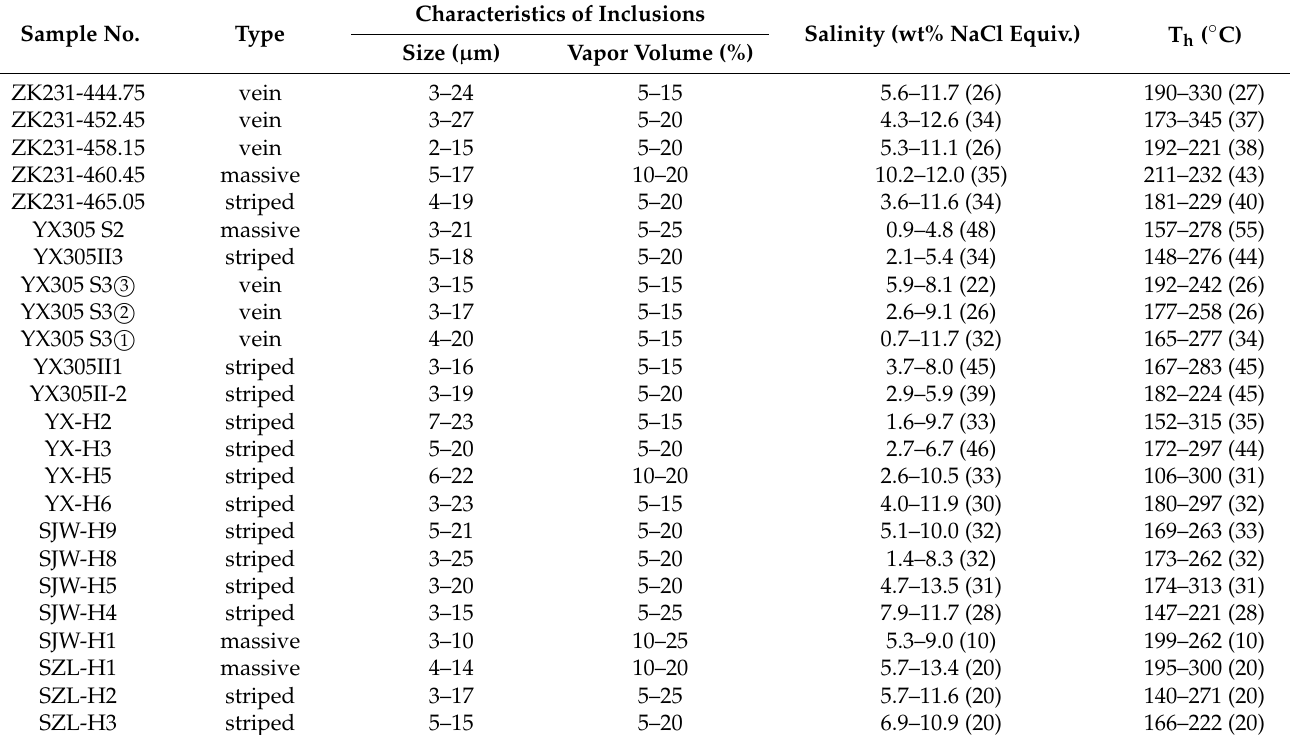
Table 2. Summary of the microthermometric data of fluid inclusions in the celestine from the celestine deposits in the Xishan anticline. (Numbers in parentheses represent the number of measurements, and T h represents homogenization